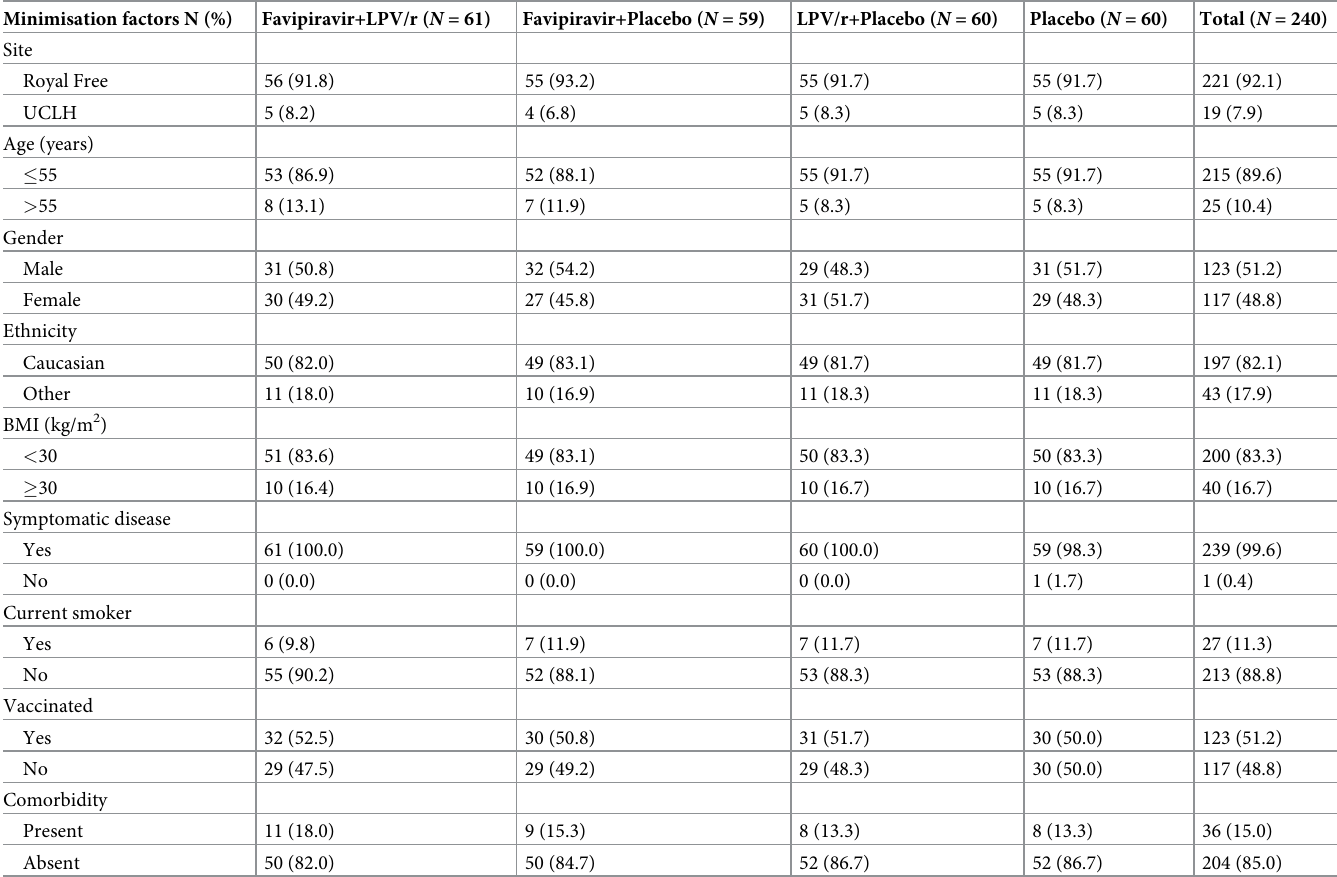
Table 2. Participant minimisation